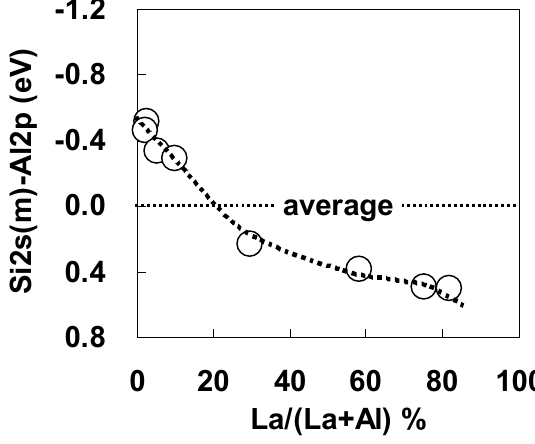
Figure 38. La/(La + Al) dependence of the energy difference between Al 2p and Si 2s. The vertical axis of the graph represents the energy difference as the divergence from the average value (average for all specimens).